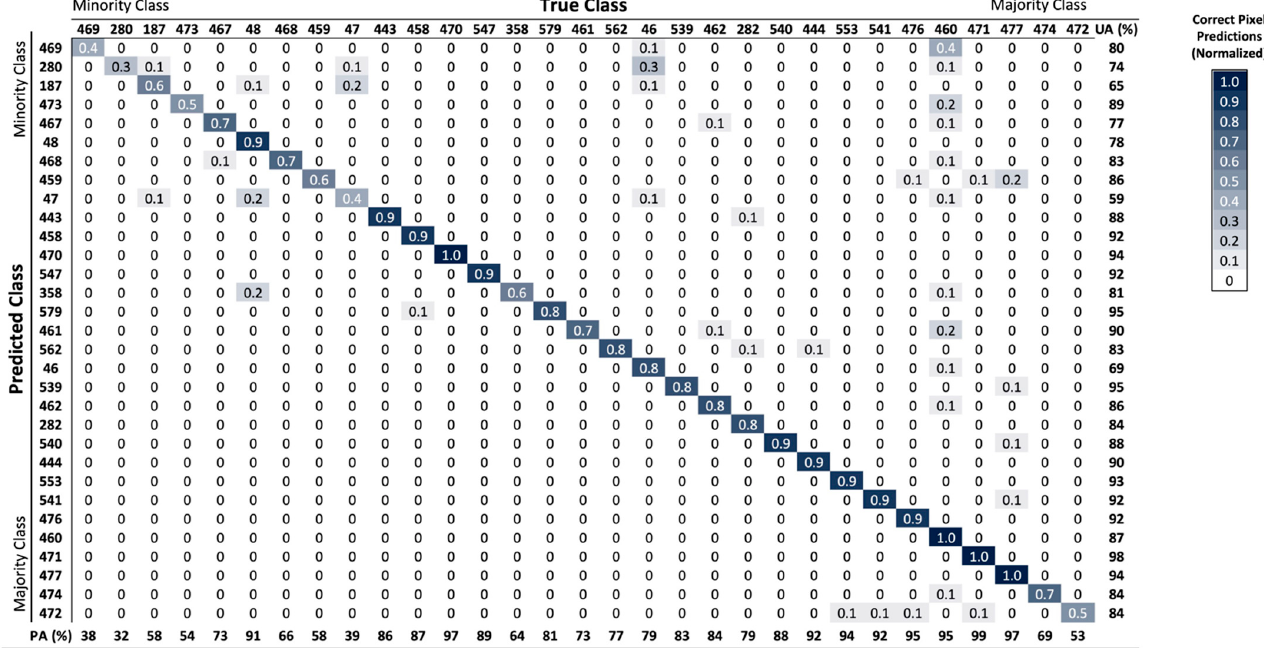
Figure 6. The final confusion matrix generated from the RF model with an overall F-score of 0.80 and OA of 91.68%. Classes are listed in ascending order based on the number of pixels in each class. Numerical values and gradient color of the cells represent the normalized value of correct pixel predictions. UA (%) scores are included for each class within the last column and PA (%) scores within the last row. Land cover names for each land cover class number can be referenced in Table 4 and total pixel counts for each class can be referenced in Figure 4.